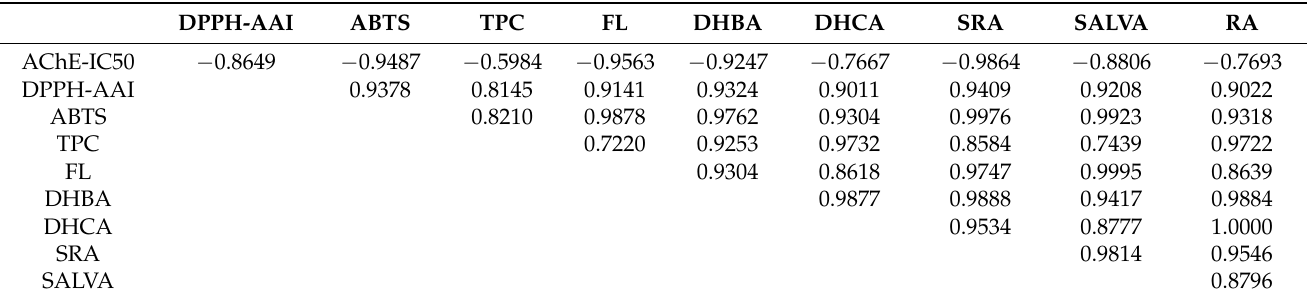
Table 4. Pearson correlation coefficients between the AChE inhibition and antioxidant activity and the main compound content